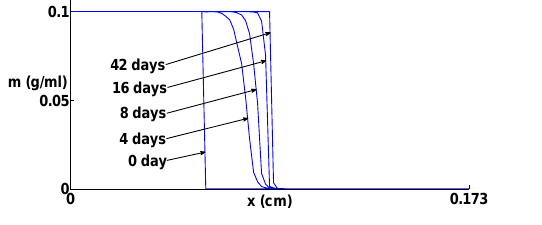
Fig. 5: Bone matrix density along the line y = x as a function of distance to the origin ( x, y ) = (0 , 0)